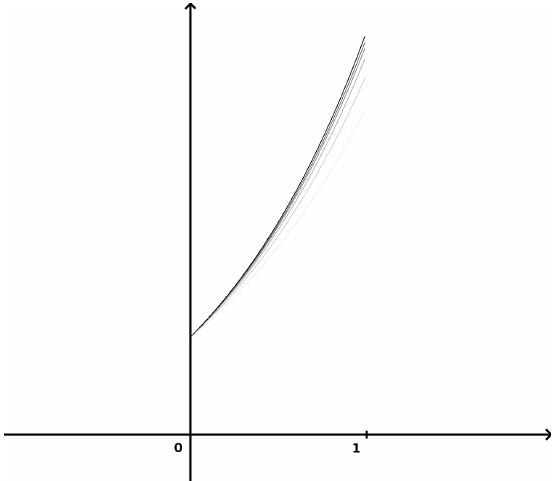
Figure 1. Uniform convergence of the modified generalized Hadamard integrals of order 2 of the function e x on the interval ]0 , 1]. As the grey level becomes darker the value of the parameter w increases of a factor 2 starting from 10. Seven approximations are shown, therefore from w = 10 up to w =